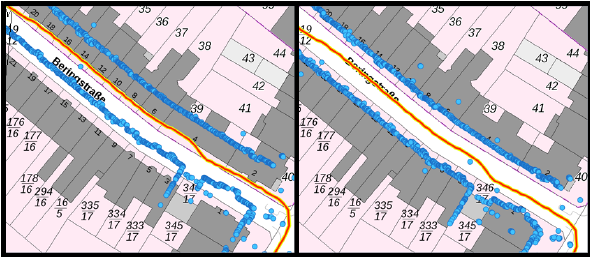
Figure 9. Impact of our approach on the recorded trajectory (left). The corrected trajectory (right) using our method. The underlying point cloud